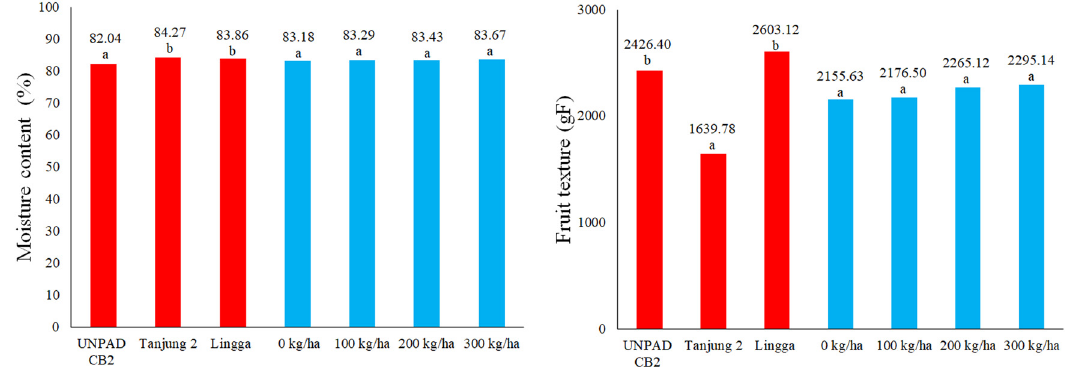
Figure 2: E ff ect of individual treatment of variety ( red ) and potassium fertilizer ( blue ) on fruit moisture content and texture. For each group color, the same letters indicate not signi fi cantly di ff erent means within each group